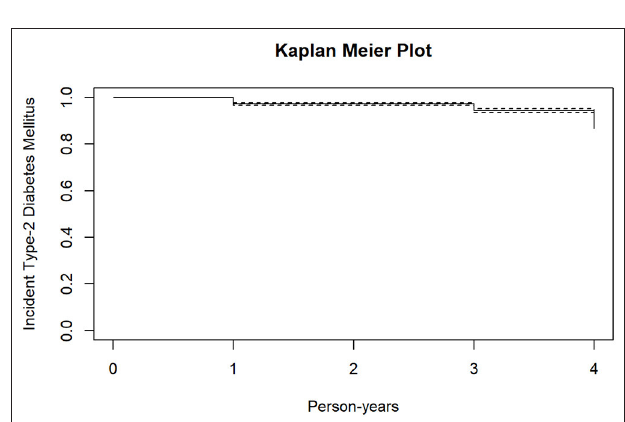
FIGURE 1 | Flow-chart of participant selection process.